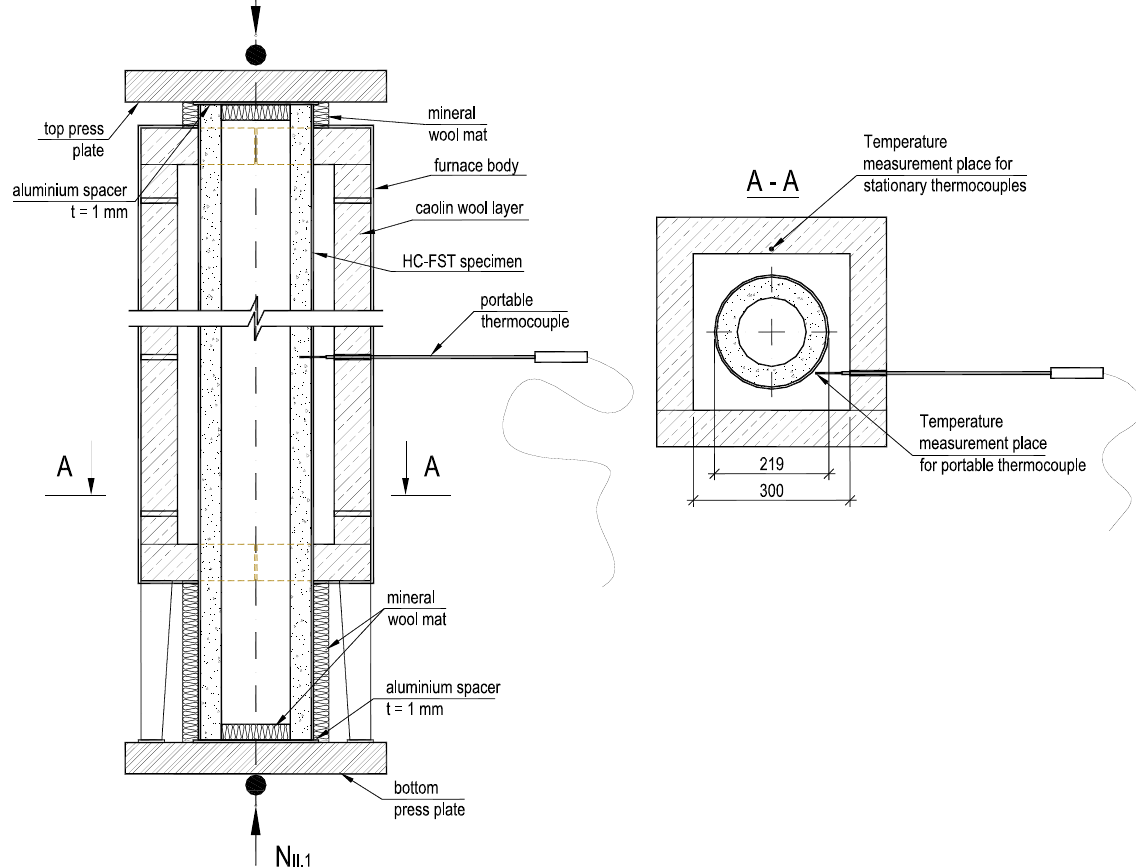
Fig 6 . Specimen installation scheme for testing under elevated